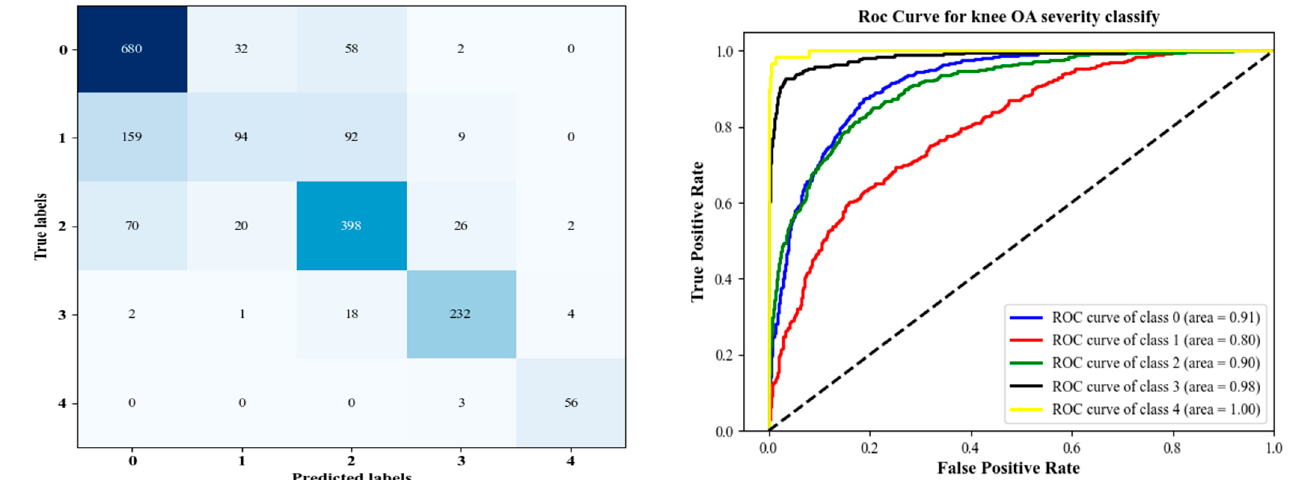
Figure 13. The confusion matrix for KL grading is shown on the left, and the Roc curve of SVM with 99% PCA components produced from 200 features is shown on the right.